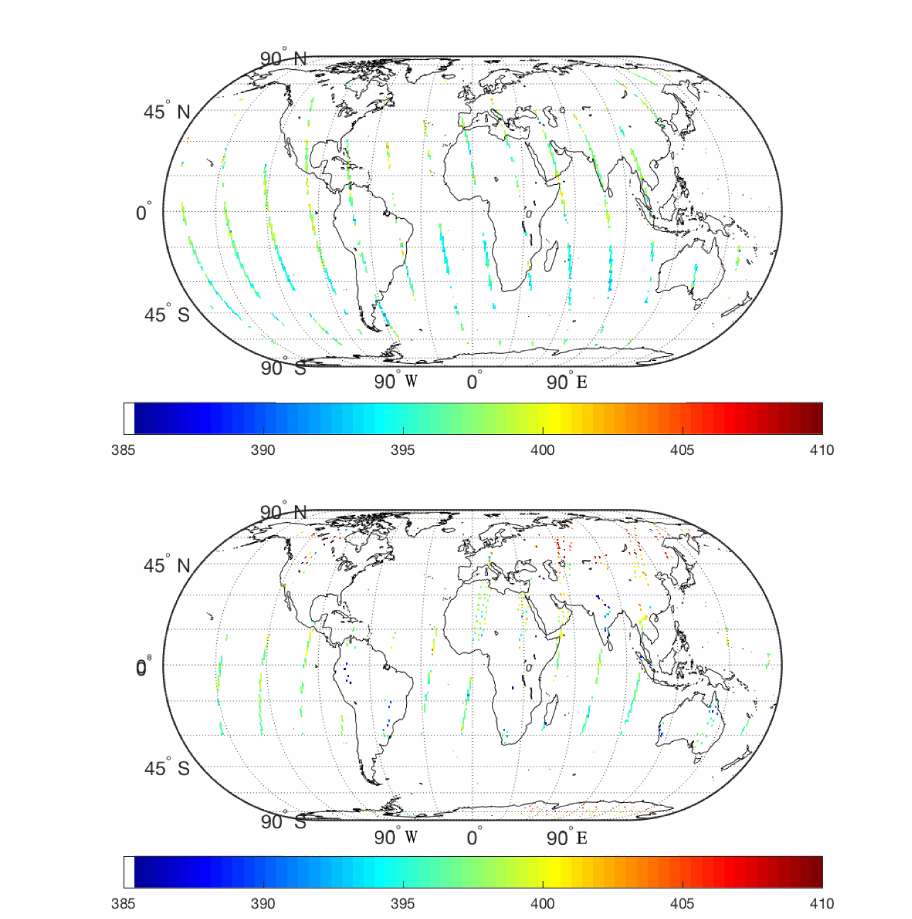
Figure 2. Retrieved column-averaged CO 2 data from OCO-2 ( top panel ) and ACOS (GOSAT) ( bottom panel ) on 3 March